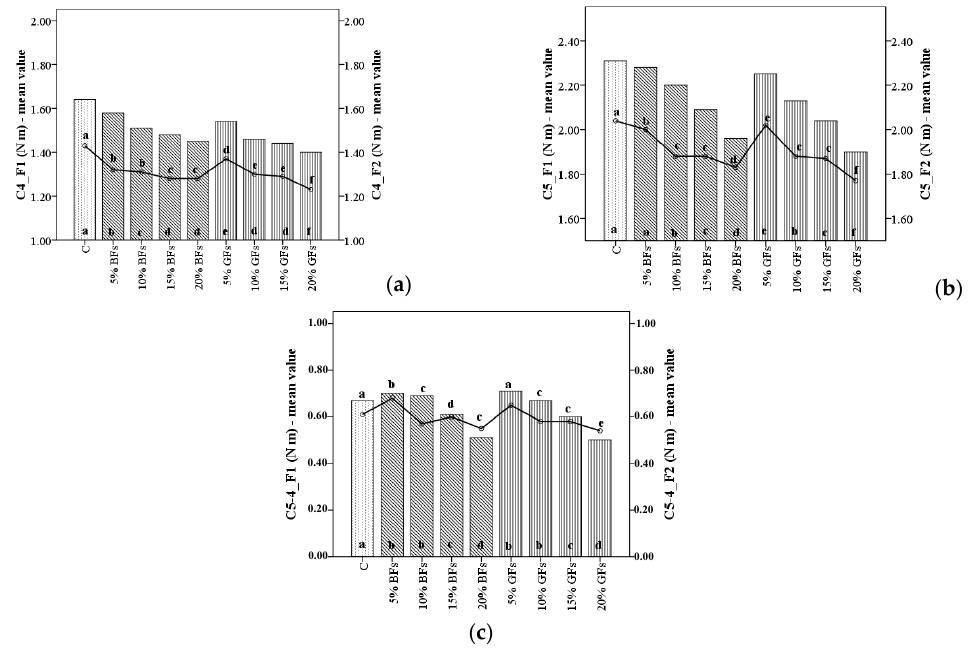
Figure 4. C4 torque ( a ), C5 torque ( b ) and difference between torques C5 and C4 (C5-4) ( c ) of WF (C) and flaxseed–wheat composite flours formulated by adding different levels (5%,10%,15% and 20%) of brown flaxseed (BFs) and golden flaxseed flour (GFs) in two types of flour, F1 and F2. Different letters indicate significant differences ( p < 0.05) between samples.